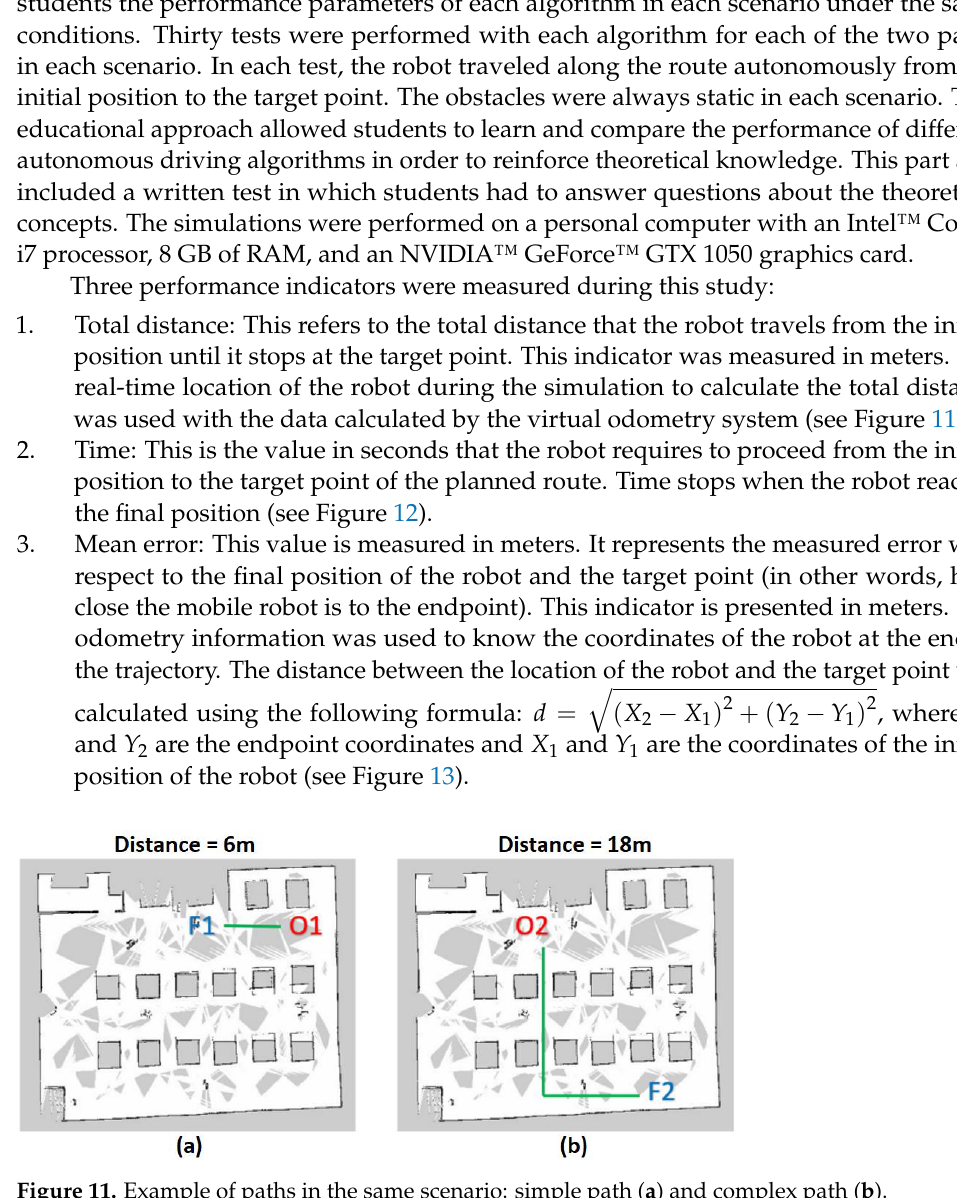
Figure 11. Example of paths in the same scenario: simple path ( a ) and complex path ( b ).